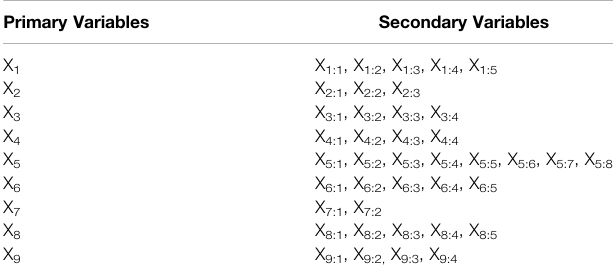
TABLE 4 | Multi- input-output indicators of national park